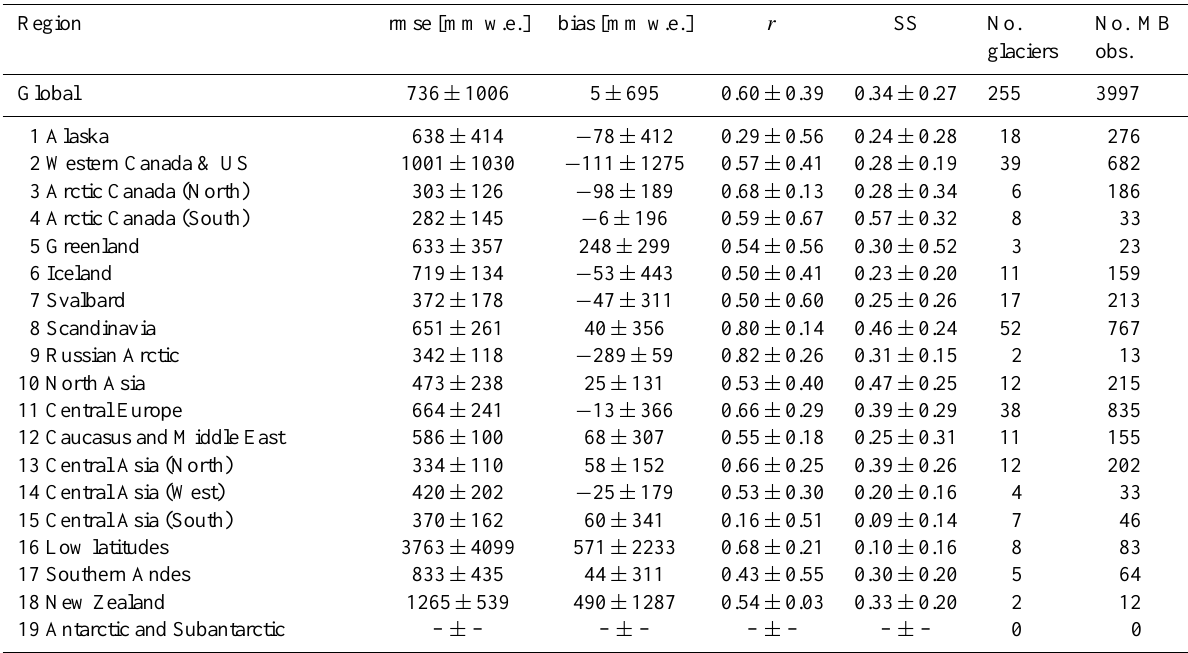
Table 1. Summary of the results of the cross-validation of the reconstructed mass balances. All numbers given are the means of the values and their standard deviations, calculated over the glaciers within each